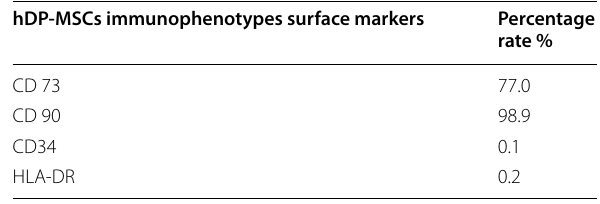
Table 3 Flow cytometry of the hDP‑MSCs immunophenotypes surface markers